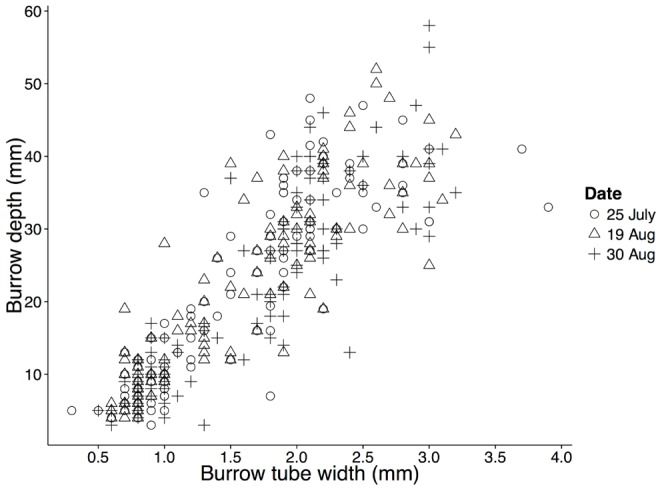
Depth (mm) versus tube width (mm) of Corophium volutator burrows in Pecks Cove in summer 2011.Burrow measurements were taken from polymer resin casts of naturally occurring burrows on three sampling dates, with n = 3, 5 and 6 casts, respectively. These dates were selected to roughly coincide with before arrival, peak abundance and departure of shorebirds. The linear regression coefficients for depth (mm) vs. width (mm) of burrows are 15.4±0.5 (SE) for the slope and −2.7±0.9 for the intercept.